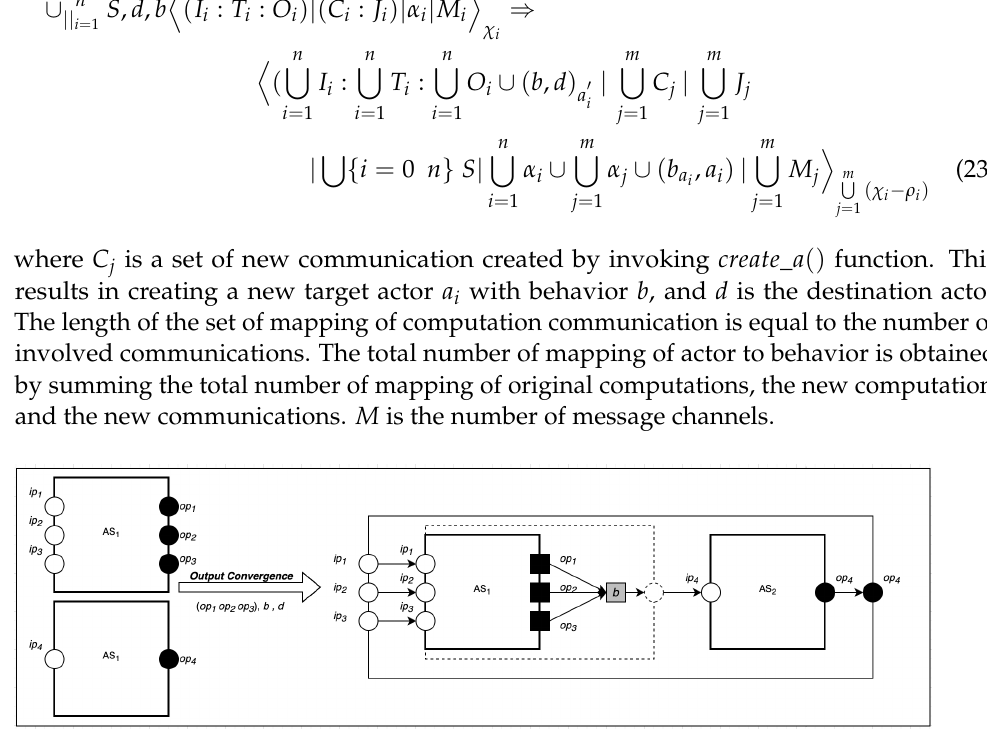
Figure 3. Output Convergence